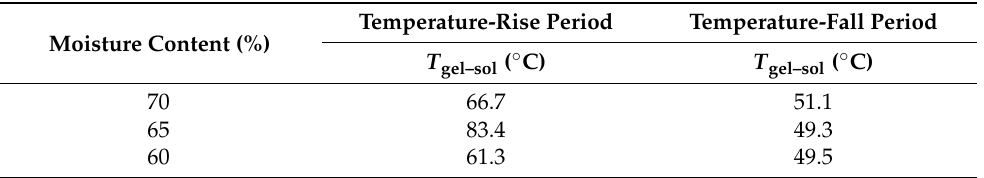
Table 3. Gel–sol transition temperature ( T gel–sol ) of calcium caseinate premixes at the moisture content of 60%, 65%, and 70% during temperature sweep